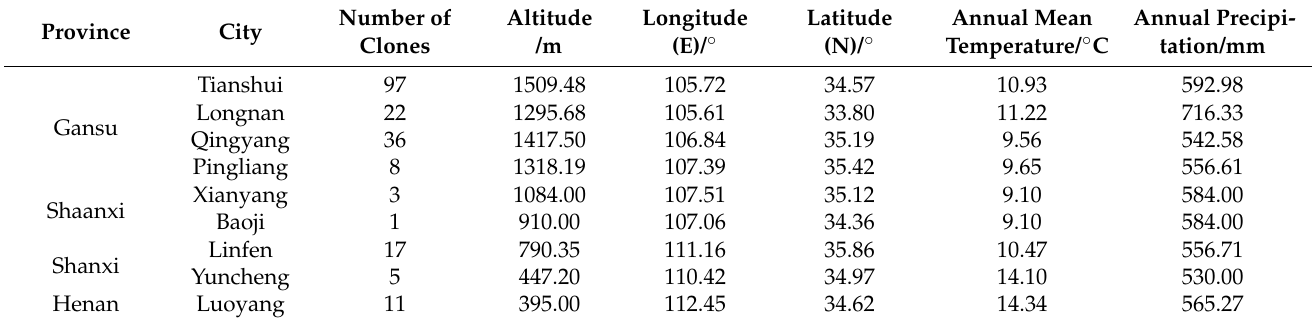
Figure 1. Distribution map of tested clones. A total of 200 clones were sampled across the 9 Prove- nance (asterisk) from Gansu ( ), Shaanxi ( ), Shanxi ( ) and Henan Province( ). Table 1. Source of tested clones.